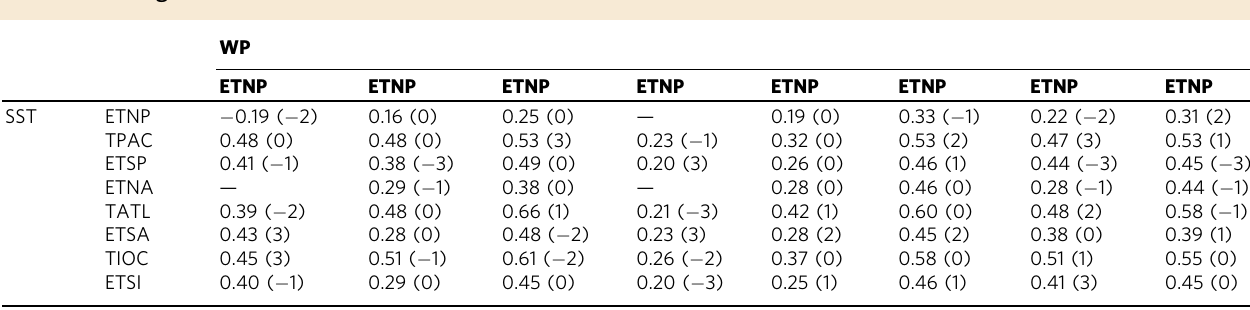
Seasonal correlations between average Sea Surface Temperature anomalies in a given sub-basin (rows) and Wave Power in a given sub-basin (columns) calculated for the period 1948 – 2008. The fi rst value corresponds to Pearson's linear correlation coef fi cient at the 95% con fi dence interval, while the second value (in parentheses) gives the time lag for the maximum correlation found. The values in parentheses represent the time lag in terms of the number of seasons. Equivalent numbers for the satellite era and correlations with no time lag can be found in the Supplementary Information ETNP extratropical North Paci fi c, TPAC tropical Paci fi c, ETSP extratropical South Paci fi c, ETNA extratropical North Atlantic, TATL tropical Atlantic, ETSA extratropical South Atlantic, TIOC tropical Indian Ocean, ETSI extratropical South Indian